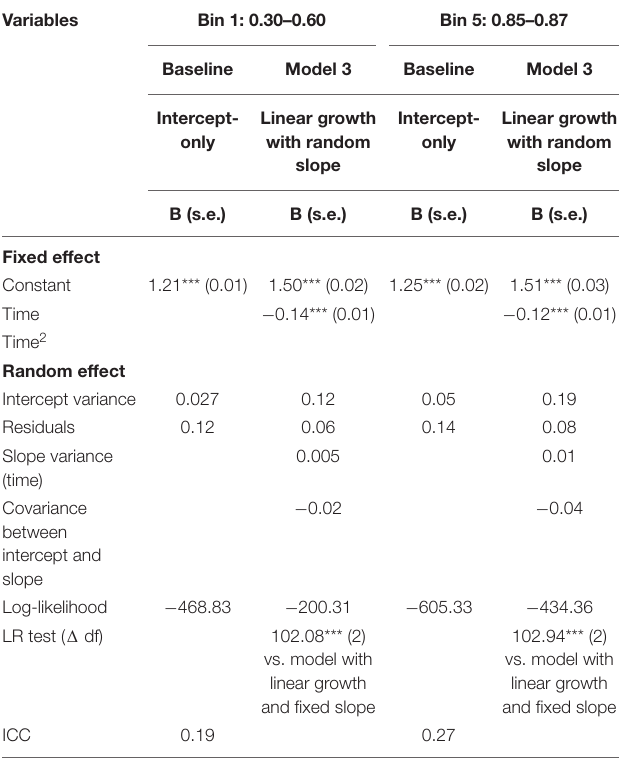
TABLE 10 | Cohort 1: results of ME growth models for changes in ANS RT (in sec.) for the easiest (0.30–0.60) and hardest (0.85–0.87) ratio bins from grade 1 to grade 5.